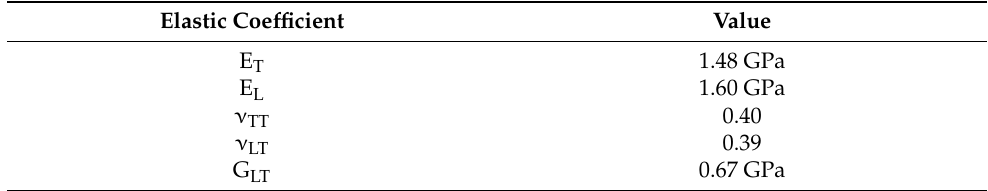
Table 6. Material properties matrix.